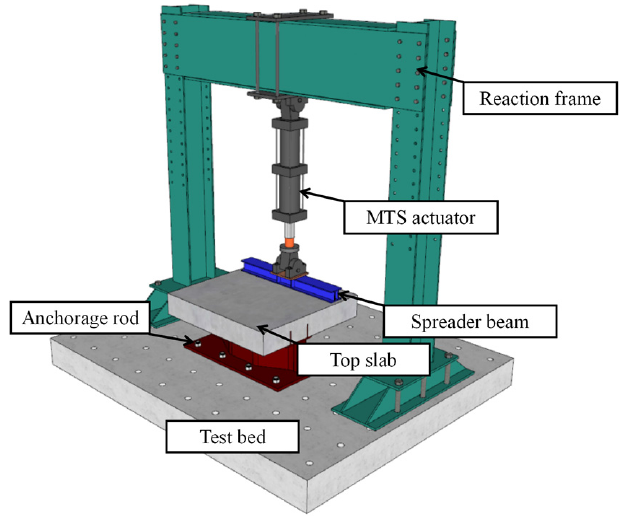
Figure 4. Test setup.